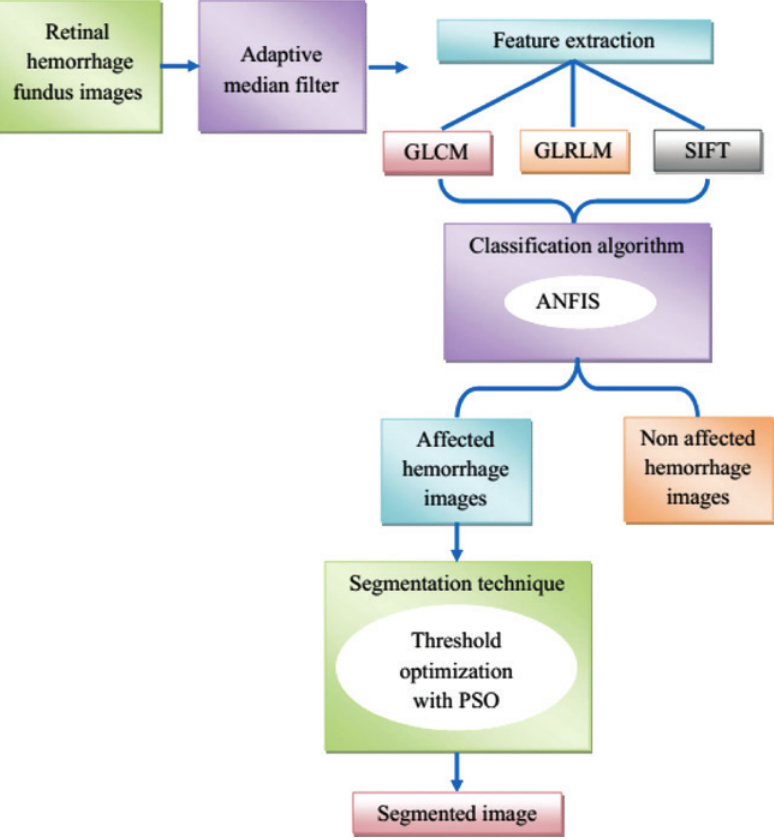
Figure 1: Overall Diagram for Proposed